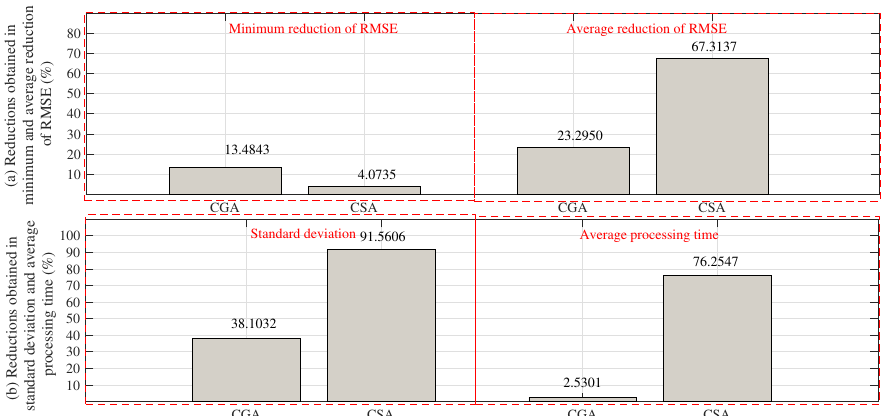
Figure 6. Reductions obtained by the VSA: ( a ) minimum and an average reduction of RMSE (%). ( b ) Standard deviation and average processing time